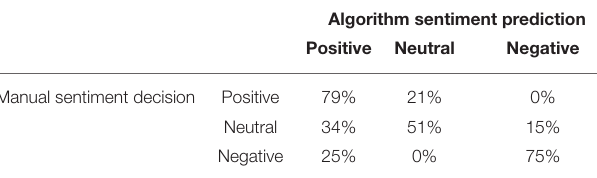
Algorithm sentiment